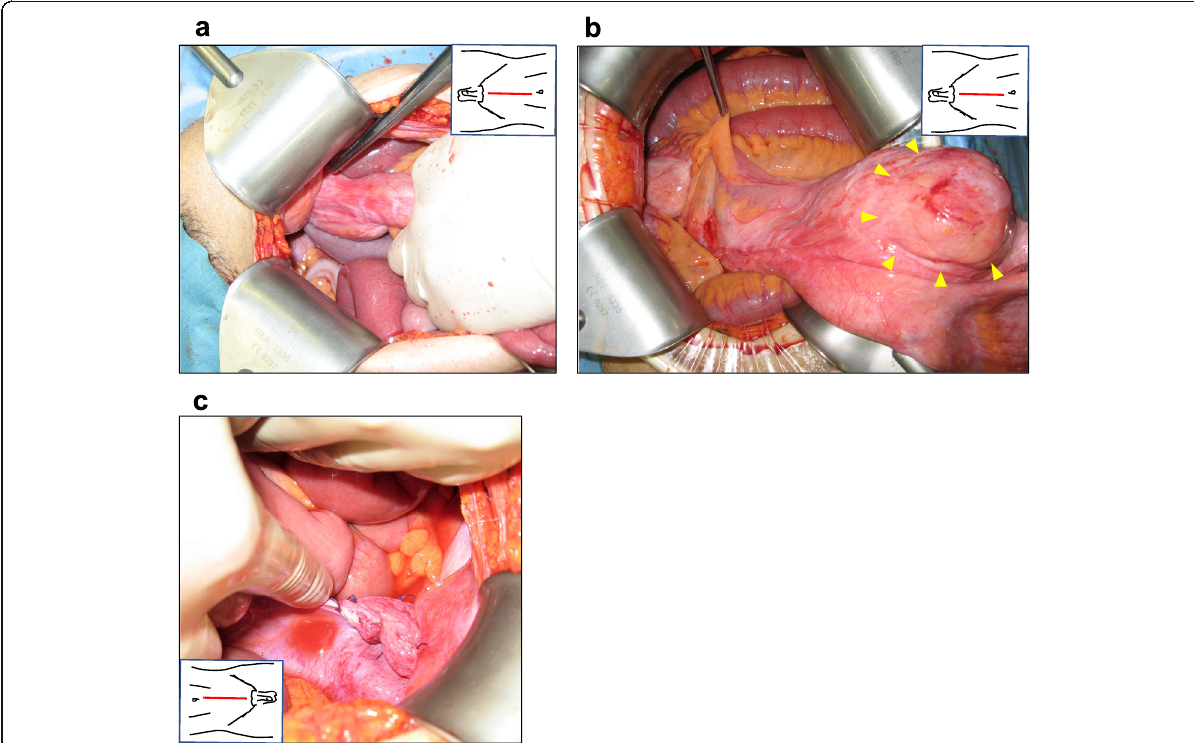
Fig. 2 a The small bowel tumor, located at 30 cm from the ileum end, was incarcerated within a right inguinal hernia. b After adhesiolysis, the tumor (arrowheads) was reduced into the peritoneal cavity. c The reduced hernia sac was ligated, and the bottom of the hernia sac was resected from the peritoneal cavity